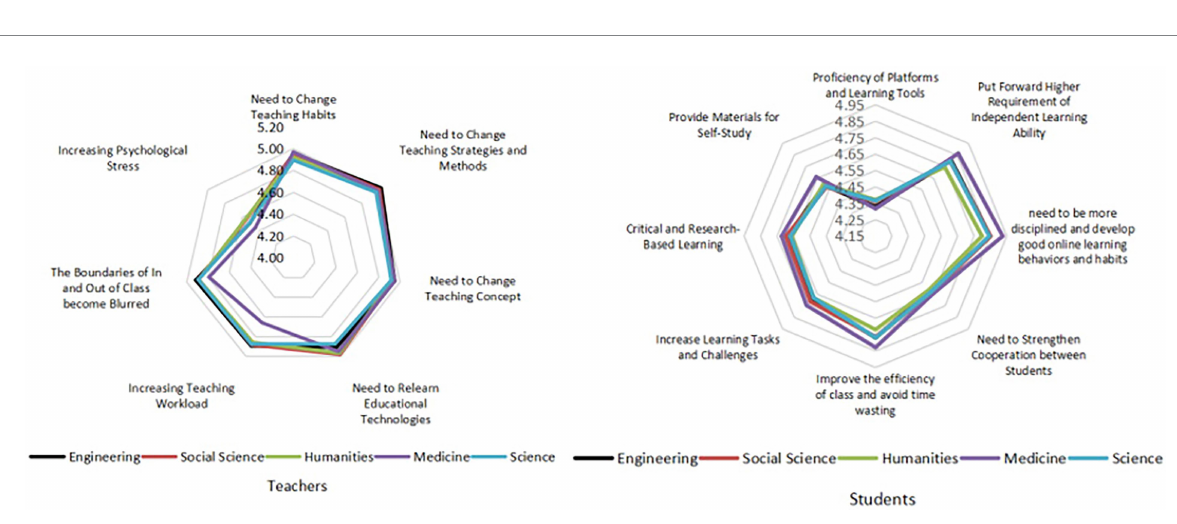
with teachers, confirming that humanities students have a high degree of classroom participation and proper online interaction.